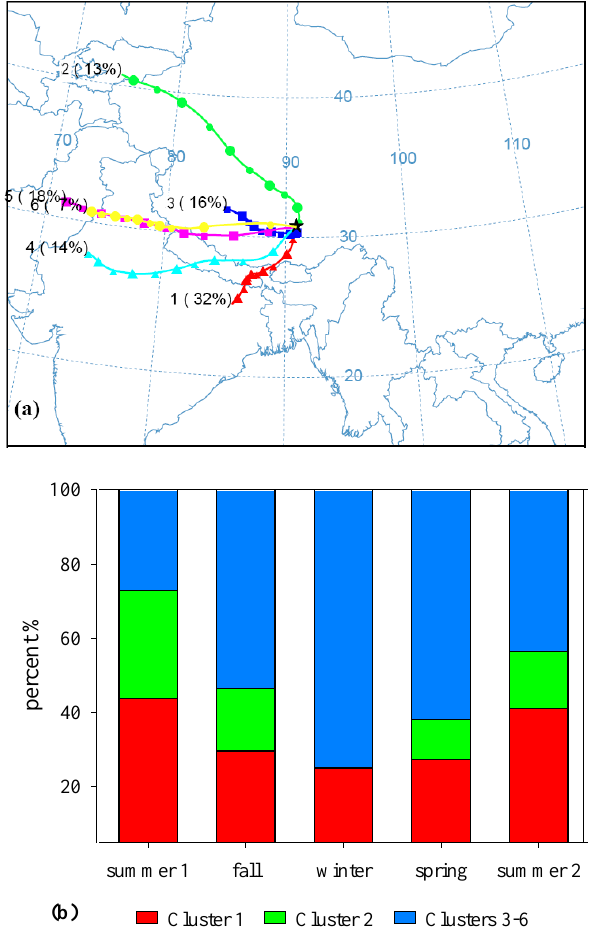
Figure 9. Cluster analyses of air masses at the NC site (a) and sea- sonal variations of clusters (b) , based on 5-day backward trajecto- ries during the sampling period. Summer 1 is from July to Septem- ber 2012, fall is from October to November 2012, winter is from December 2012 to February 2013, spring is from March to May 2013, summer 2 is from June to July